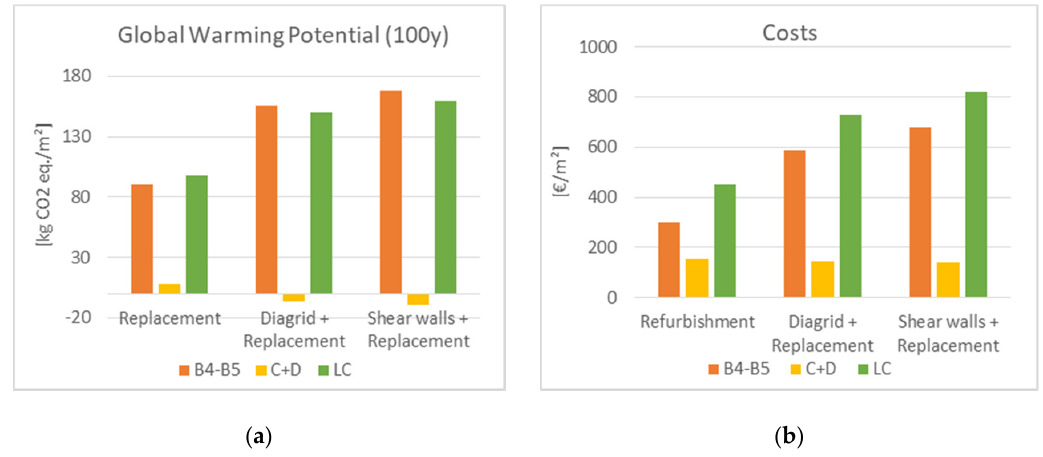
Figure 4. ( a ) LCIA and LCC ( b ) results, by considering B4–B5, C + D life-cycle modules.